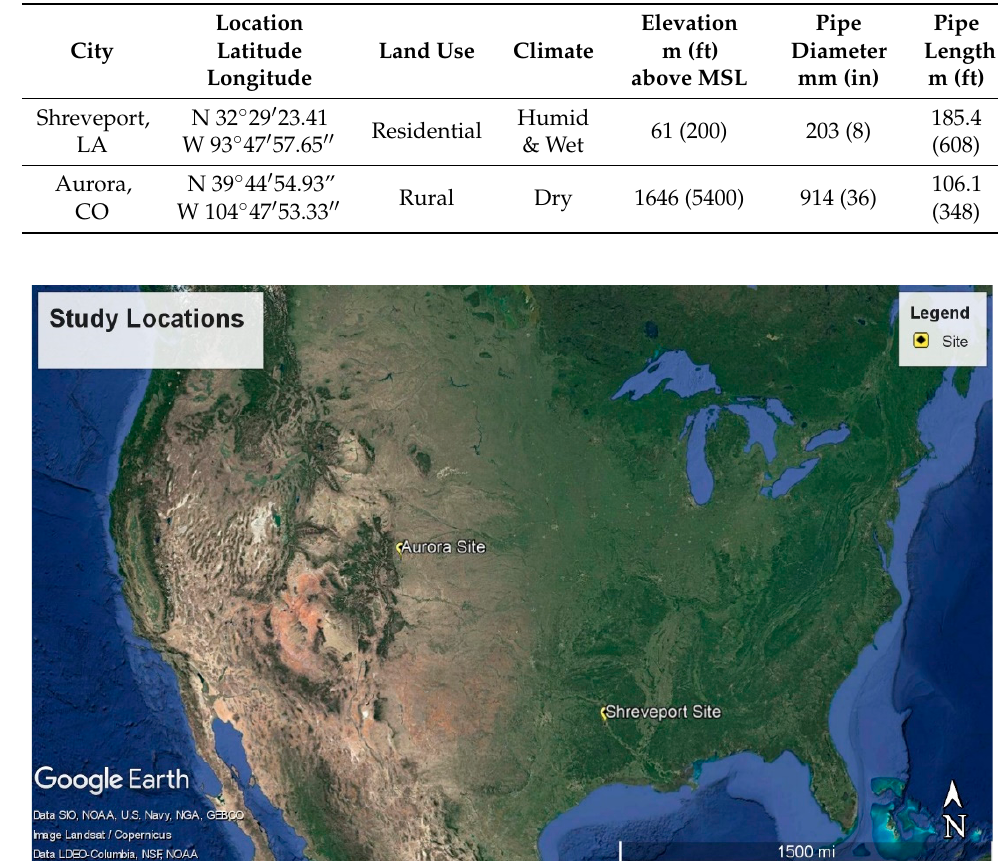
Table 1. Site Location and Pipe Characteristics for Shreveport, LA and Aurora, CO, USA.